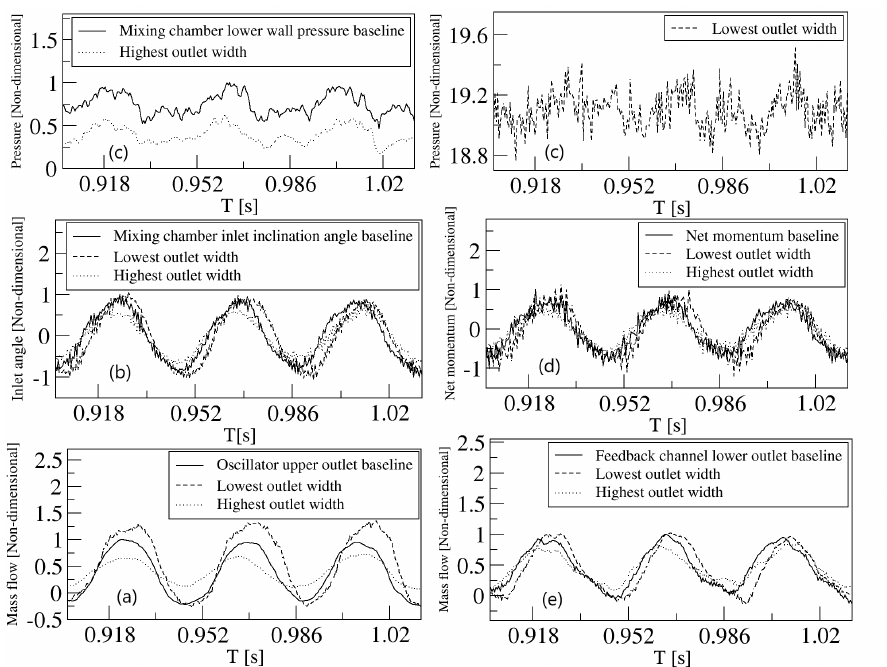
Figure 9. Dynamic effects of the (MC) outlet width modification on the main flow parameters, Reynolds number 16034. Each graph presents three non-dimensional curves characterizing results from the baseline, the lowest and highest outlet width cases, and as a function of the dimensional time. In figure ( a ) the mass flow across the upper oscillator outlet is presented. Figure ( b ) introduces the temporal variation of the (MC) inlet inclination angle. Figures ( c ) presents the pressure at the (MC) lower inclined wall. The net momentum acting on the lateral sides of the main jet is presented in figure ( d ). Figure ( e ) characterizes the mass flow at the lower feedback channel